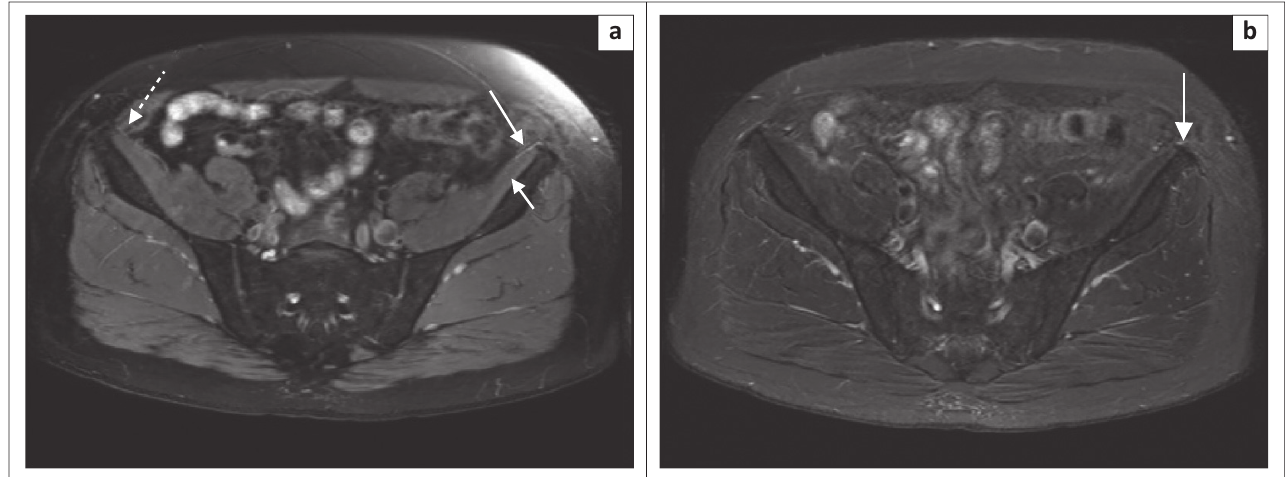
FIGURE 2: 3T proton density fat-saturated axial MR images at the level of the anterior superior iliac spine in a 54-year male patient presenting with a clinical suspicion of meralgia paresthetica on the left. Note the high signal and prominence of the lateral femoral cutaneous nerve on the left (long arrow) as compared to the right (dashed arrow) as it runs over the (a) iliacus muscle (short arrow) and (b) anterior superior iliac spine.